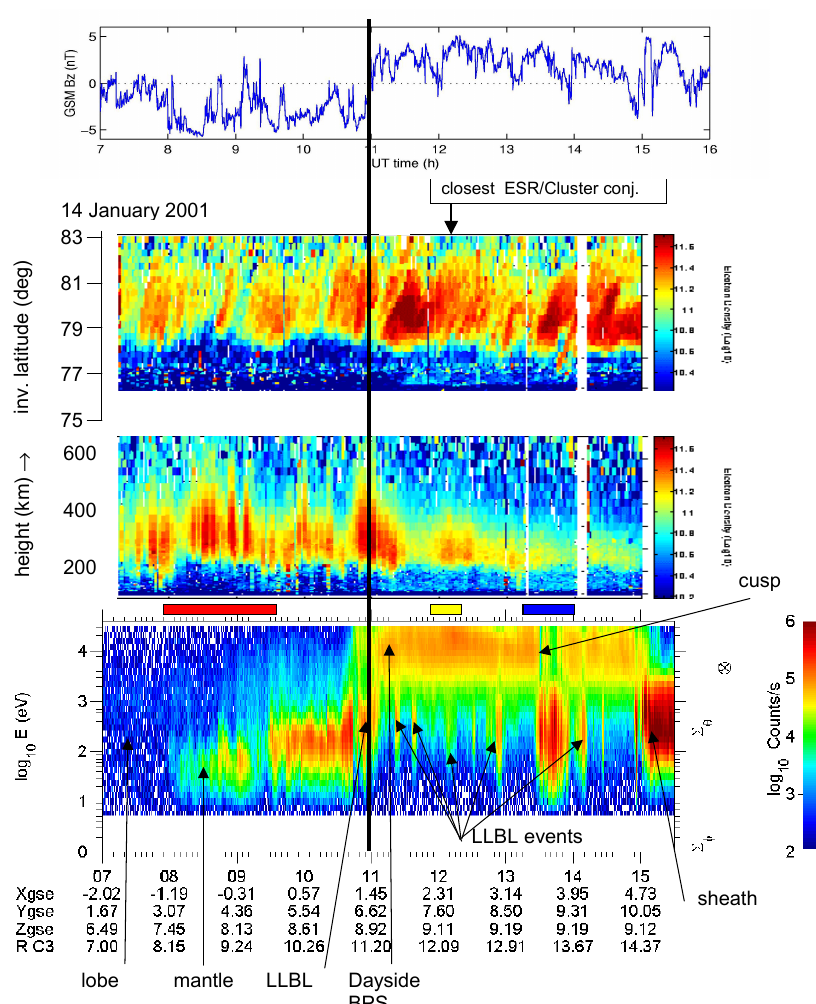
closest ESR/Cluster conj.